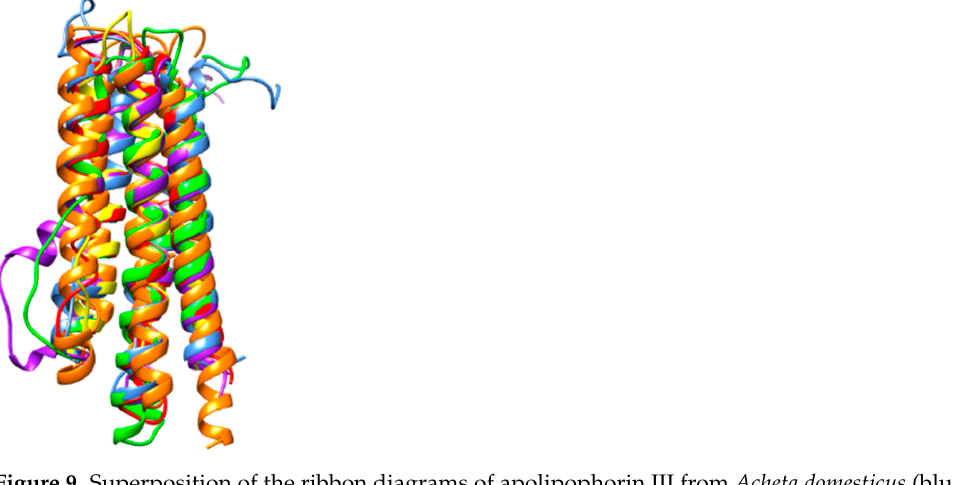
Figure 8. Multiple amino acid sequence alignment of apolipophorin III from Galleria mellonella ( Galleria m. ), Bombyx mori ( Bombyx m. ), Schistocerca g. ( Schistocerca g. ), Acheta domesticus ( Acheta d. ), Tenebrio molitor ( Tenebrio m. ) and Locusta migratoria ( Locusta m. ). Identical amino acids are displayed in white letters highlighted in blue, homologous amino acids are displayed in black letters highlighted in cyan, and putative N -glycosylation sites are highlighted in red.